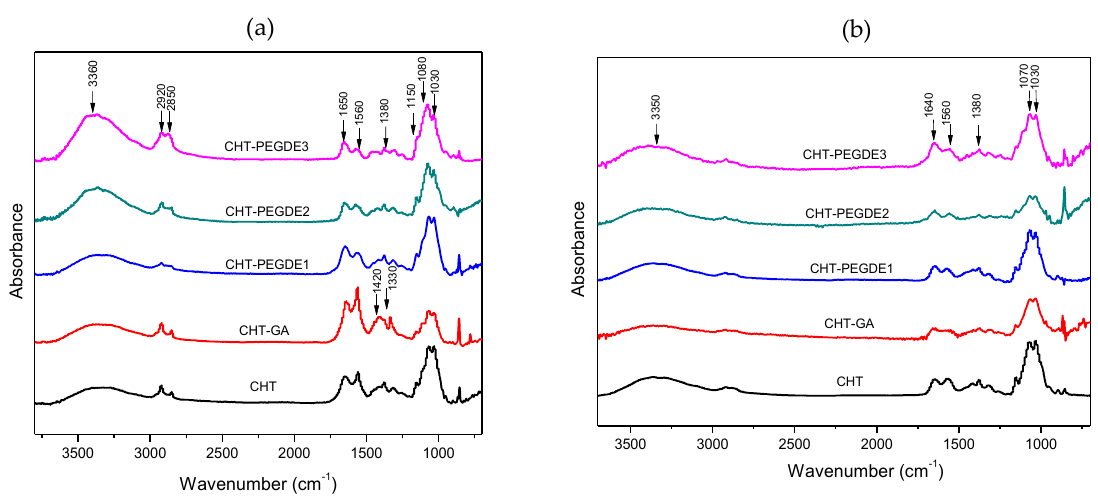
Figure 1. ( a ) Fourier-transform infrared spectroscopy (FTIR) spectra of Chitosan (CHT) films dried at 25 °C ( b ) FTIR spectra of CHT films dried at 150 °C.